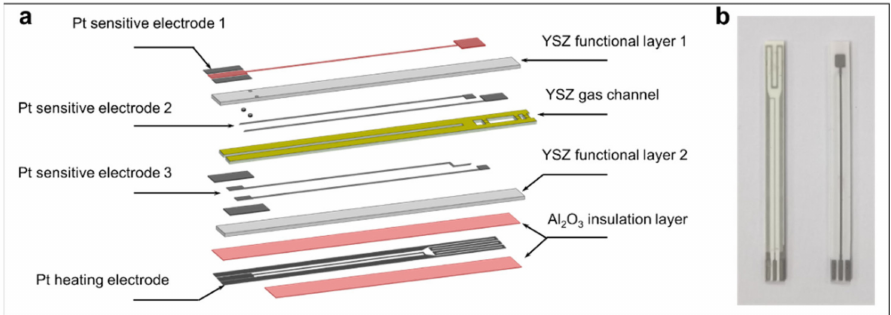
Figure 1. The planar nitrogen–oxygen sensor: ( a ) schematic structure via an exploded view of the sensor; ( b ) outside view of the two sides of the